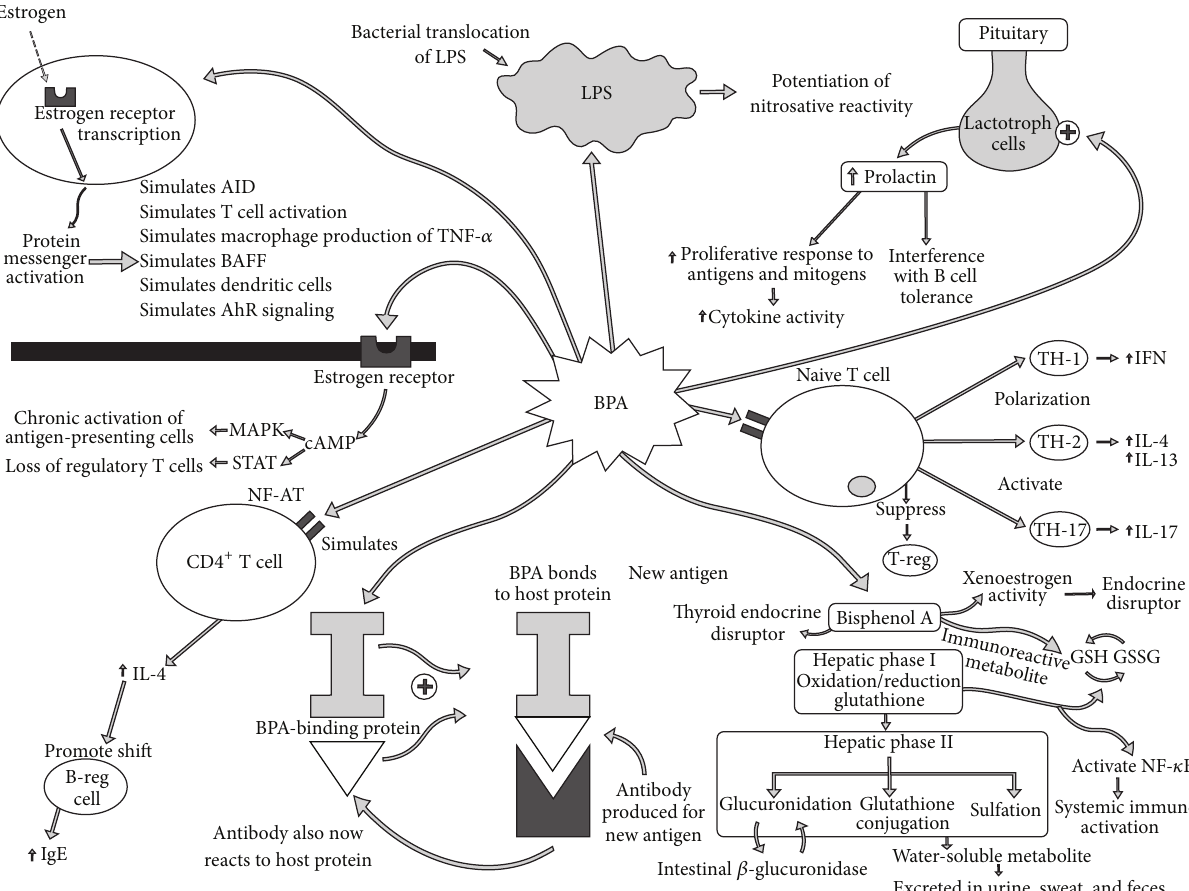
Figure 13: Potential of various autoimmune mechanisms from bisphenol